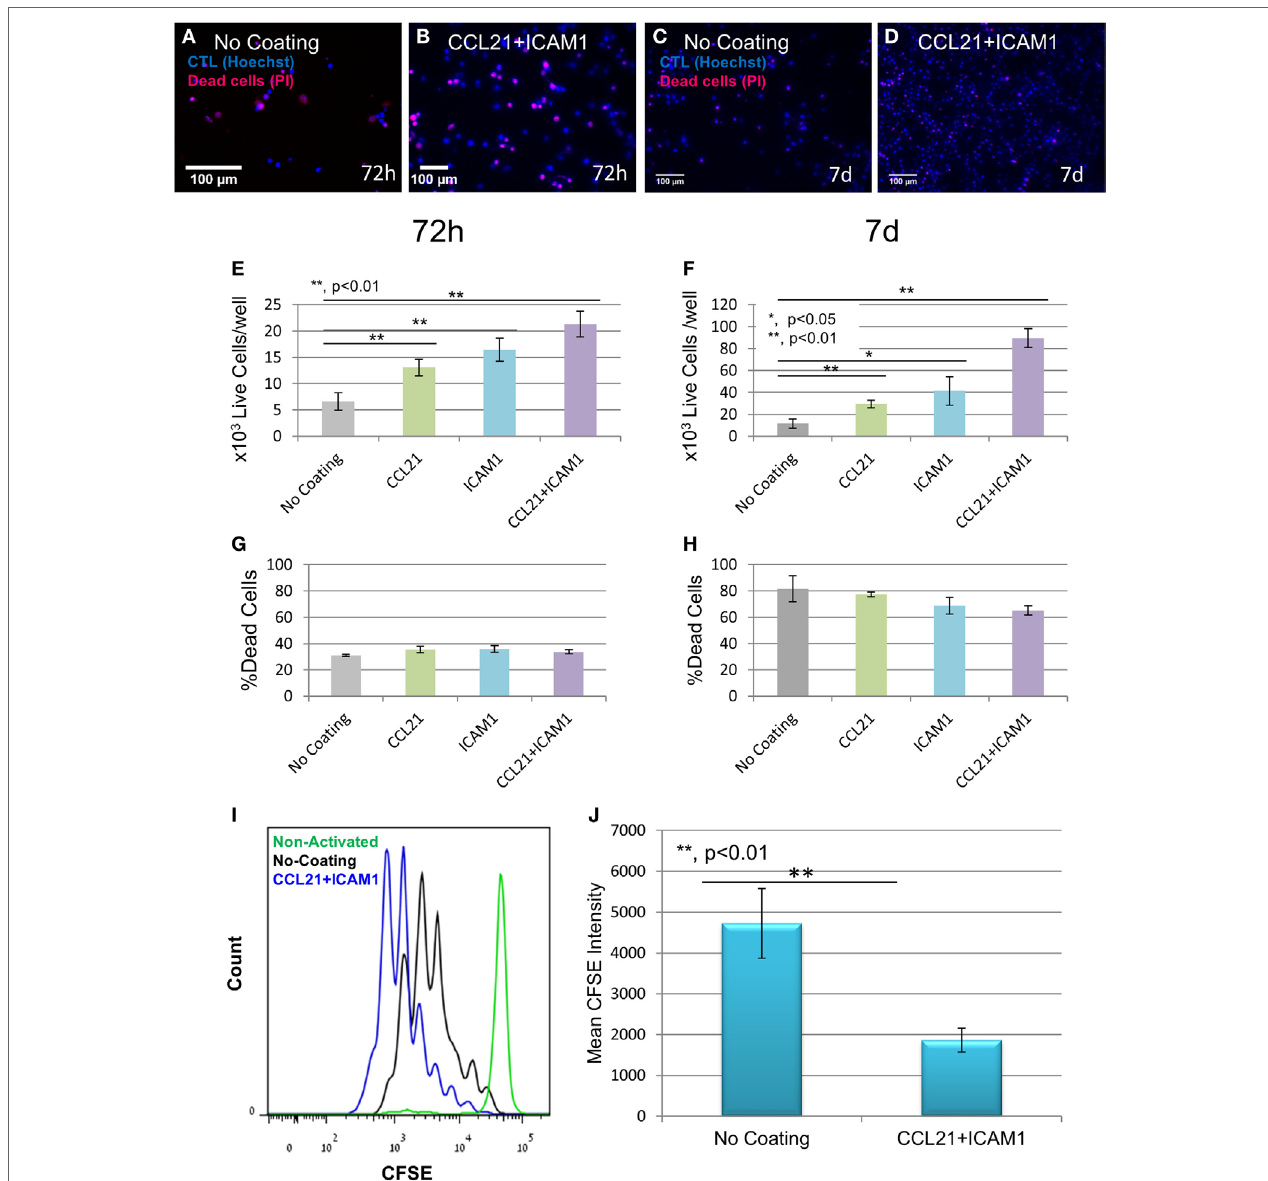
FigUre 2 | Substrate-immobilized CCL21 + intercellular adhesion molecule 1 (ICAM1) increase cytotoxic T-cell number and proliferation. (a–D) Representative fluorescence images of T-cells grown on different coated substrates for 72 h (a,B) or 7 days (c,D) , following the breakdown of cell clusters, and their spin-down. Cell nuclei are stained blue in all cells, and red only in dead cells. Scale bar: 50 µm. (e–h) Viable cell numbers and percentage of dead cells at 72 h ( e,g , respectively) and 7 days ( F,h , respectively), quantified using automated image analysis. Data are from one experiment representative of at least three independent experiments with 20 replicates each (see Figure S1A in Supplementary Material). Error bars represent SEM. Calculated p -values (using standard t -test) are as indicated in the Figure. The number of T-cells seeded per well was 3 × 10 3 . CCL21 and ICAM1 coatings collectively increase viable cell numbers by up to ninefold, without significantly affecting cell death. (i,J) Histogram and bar graph illustrating the increase in cell proliferation induced by CCL21 + ICAM1, indicated by a decrease in the mean fluorescent intensity of CFSE, compared to cells grown on the uncoated culture (data are representative of three independent experiments with four replicates each). Error bars represent SEM. Calculated p -values (using standard t -test) are as indicated in the Figure]. Histograms in (i) show CFSE levels: green—non-activated T-cells; black —T-cells activated on uncoated substrates; blue—T-cells activated on CCL21 + ICAM1-coated